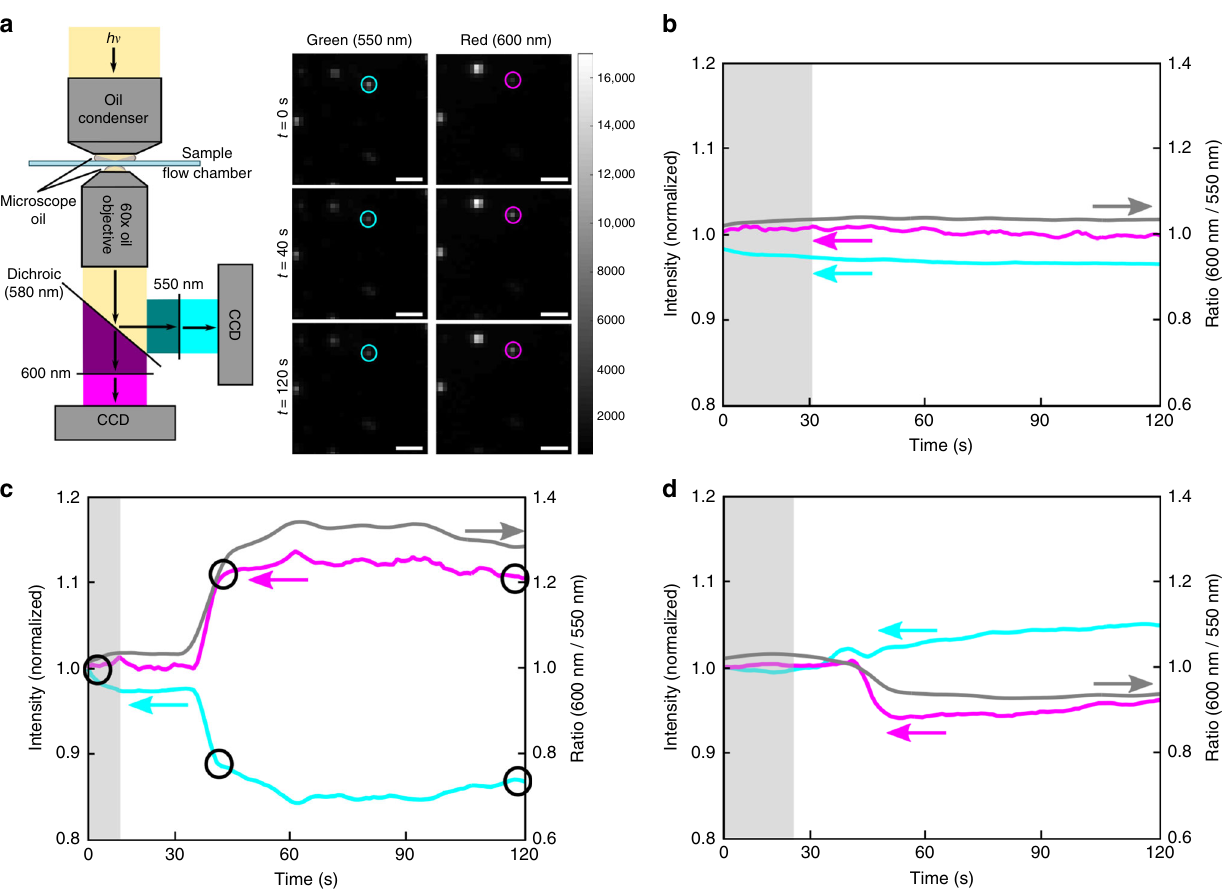
Fig. 2 Detection of resonance shifts during the formation of Pd NPs. a Schematic drawing of the ratiometric imaging set-up, with representative CCD images on the monitored wavelength channels of 550 and 600 nm (magni fi ed sub-section of the entire fi eld of view, scale bar = 10 μ m) at time points t = 0, 40, and 120 s. Plots of the monitored intensities as function of time for the circled point are shown in ( c ). b Intensities and calculated intensity ratios of PR controls (no Pd 2 + ) during the incubation with DMAB. Gray line represents the ratio of the red (600 nm, red line) and green (550 nm, green line) wavelength channels. The shaded area marks an interval without fl ow before the reducing agent was fl ushed in. c , d Sample trajectories for 15 DNA/NP PR during the reduction of Pd 2 + to Pd NPs showing c a red-shift and d a Figure 3b correlates the resonance wavelengths of PRs with 15 DNA/NP measured before ( λ initial ) and after ( λ fi nal ) Pd 2 + reduction. The resonance wavelengths of controls (PRs treated with DMAB in the absence of Pd 2 + ) and individual NPs + (monomers) in Pd 2 containing aqueous solution are included for comparison. The λ initial distribution of the PRs is red-shifted relative to that of the monomers due to near- fi eld coupling between the NPs. The broad spread of the PR λ initial values re fl ects a large variability in the interparticle separation of the immobilized PRs. Importantly, different from the PR control for which λ fi nal and λ initial are strongly correlated and the majority of the population (92%) shows a spectral shift, Δλ = λ fi nal − λ initial , of less than ±10 nm + containing PRs show a large distribution of (black line), the Pd 2 positive and negative Δλ after addition of DMAB. Only 27% of PRs cluster around the Δ λ = 0 (±10 nm) line, while 43% of PRs experience a red-shift of Δ λ > + 10 nm and, intriguingly, 30% of PRs show a blue-shift of | Δ λ | > | − 10| nm as a consequence of Pd NP formation. Figure 3c shows the spectra before and + after Pd 2 reduction of a PR that experiences a strong blue-shift of = 645 nm to λ = 550 nm. In princi- Δ λ = − 95 nm from λ fi nal initial ple, the conversion of a dimer into a monomer through loss of a NP could account for a spectral blue-shift. However, due to the + ) controls and absence of a systematic blue-shift in the PR (no Pd 2 PR scattering intensities that remain signi fi cantly higher than those